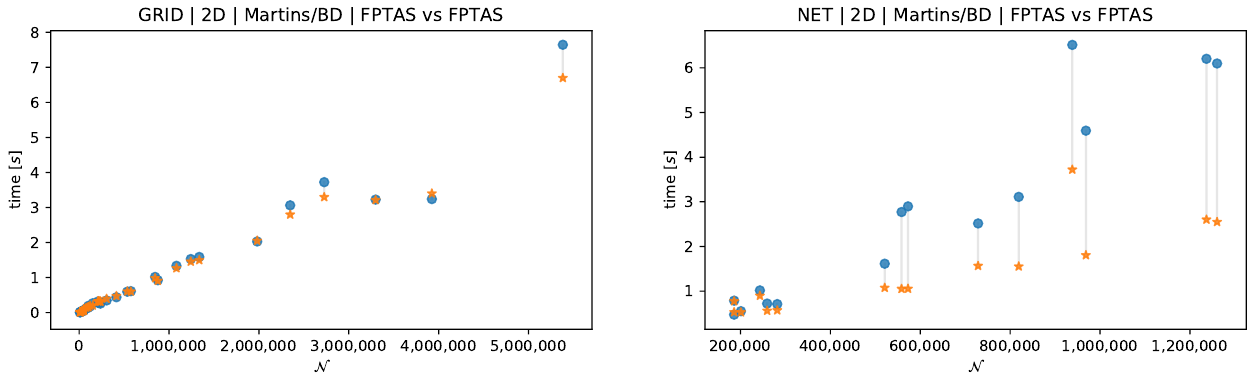
Figure 6. BD-FPTAS (yellow) and Martins-FPTAS (blue) on grid instances ( left ) and netmaker instances ( right